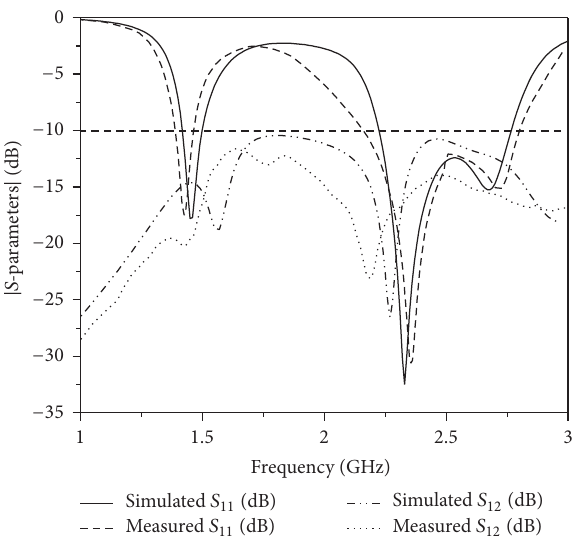
Figure 11: The simulated and measured 𝑆 -parameters (dB) for the first configuration (PIN diodes switched OFF).